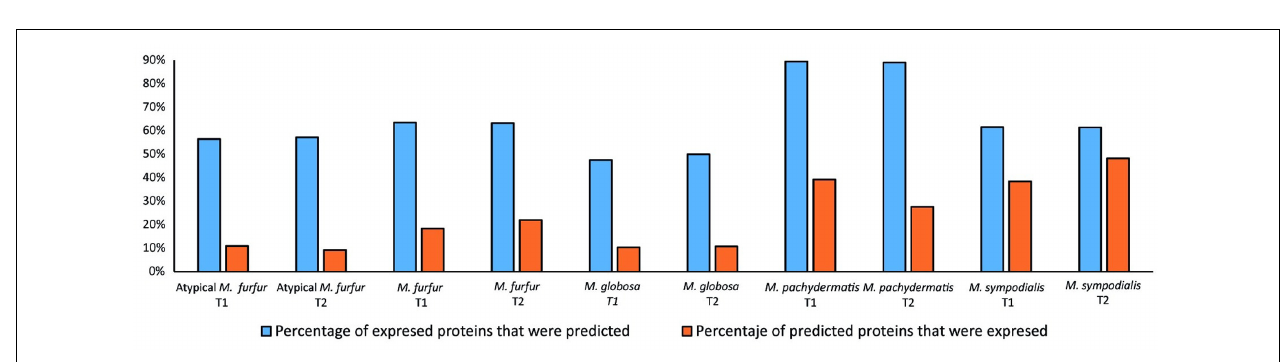
FIGURE 8 | Principal component analysis (PCA) of the expressed protein cluster for the five strains at T1 (exponential phase) and T2 (stationary phase) with four replicates.